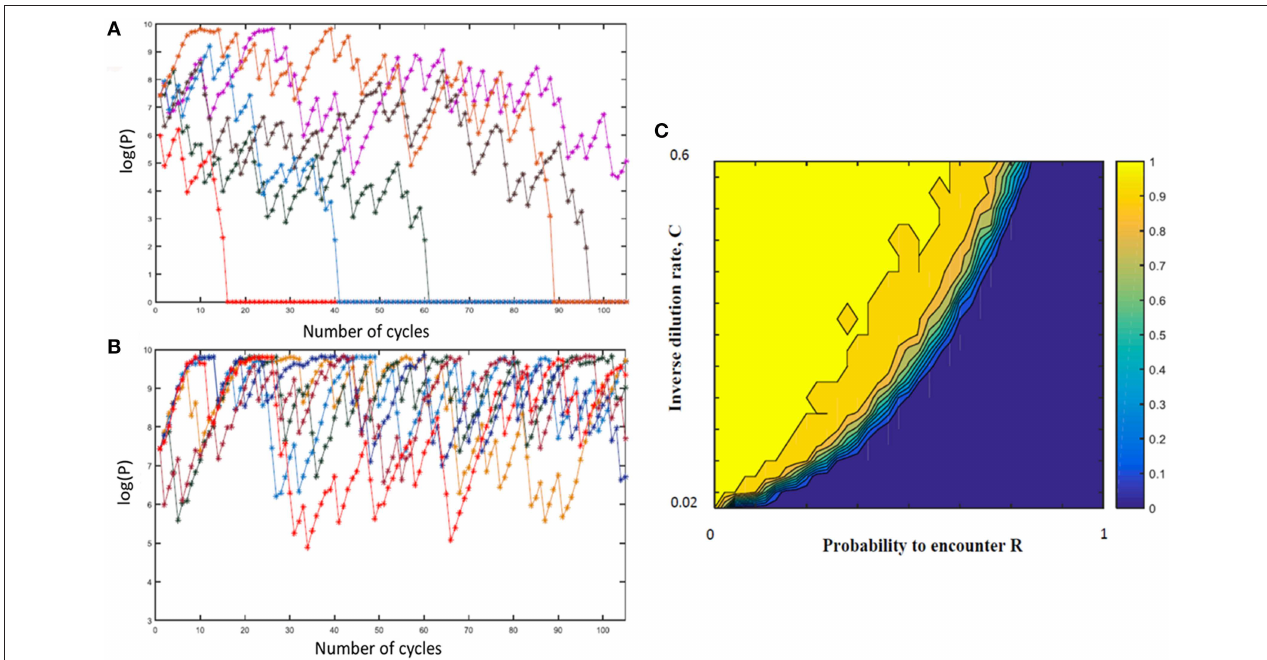
FIGURE 4 | Mathematical model of the impact of sub-population phage resistance/sensitivity composition and dilution rate on phage extinction events. This model simulates transmission of phage HP1c1 through meta-populations of H. influenzae strain Rd comprising either phage-susceptible (S, lic2A ON) or phage-resistant (R, lic2A ON) populations for 105 cycles. In these simulations, the phage is passaged through a linear series of population as outlined in Figure 1 and undertaken in Figures 2 , 3 . In contrast to the experimental model, the linear order of the S or R populations was stochastic not fixed but with the probability of encountering a resistant population ( R ) being a user-defined value. In this model, the phage population is classified as extinct if the phage titer falls below the extinction threshold ( P 0 = 100) with the titer being set to 0 for all remaining subsequent cycles. (A,B) Show examples of model outputs, which are quantified as phage densities log(P). These graphs show six iterations of meta-populations comprising either 75% (i.e., R = 0.25; A ) or 85 % (i.e., R = 0.15; B ) phage-susceptible populations. (C) Shows the mean proportion of phage extinction events occurring in 200 lineages for 200 combinations of probabilities to encounter R (i.e., 1 = 100% resistant, 0 = 0% resistant) and rates of phage loss during transmission after each cycle (inverse dilution rate, C; 0.02 = 2% of phage carried through in each transfer). Color correlations are shown on the bar to the right of the graph with 1 representing no extinction events while 0 is extinction in all